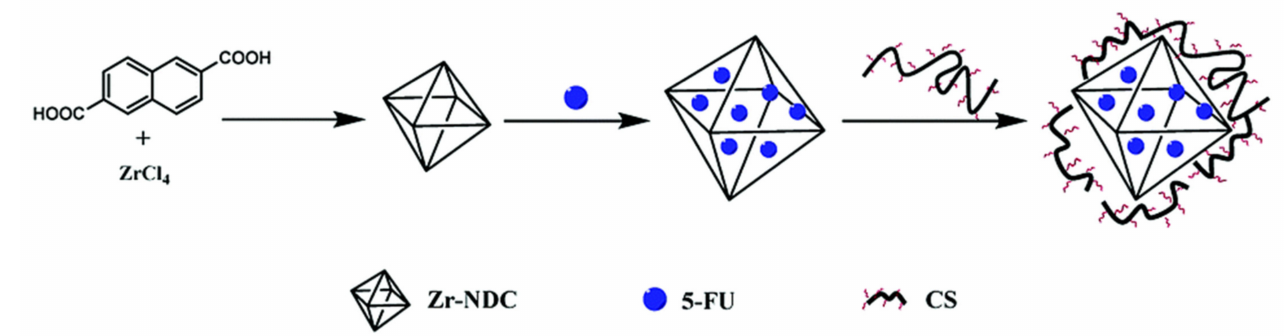
Figure 24. Synthesis of CS/MOF loaded with 5-FU [146]. Reproduced with permission from Elsevier